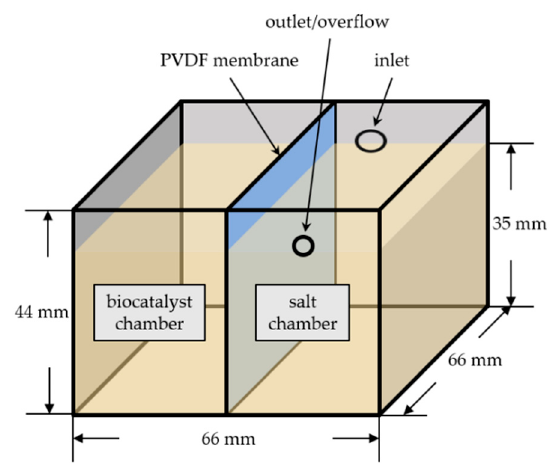
Figure 1. Design of the membrane reactor with polyvinylidene fluoride membrane (PVDF).